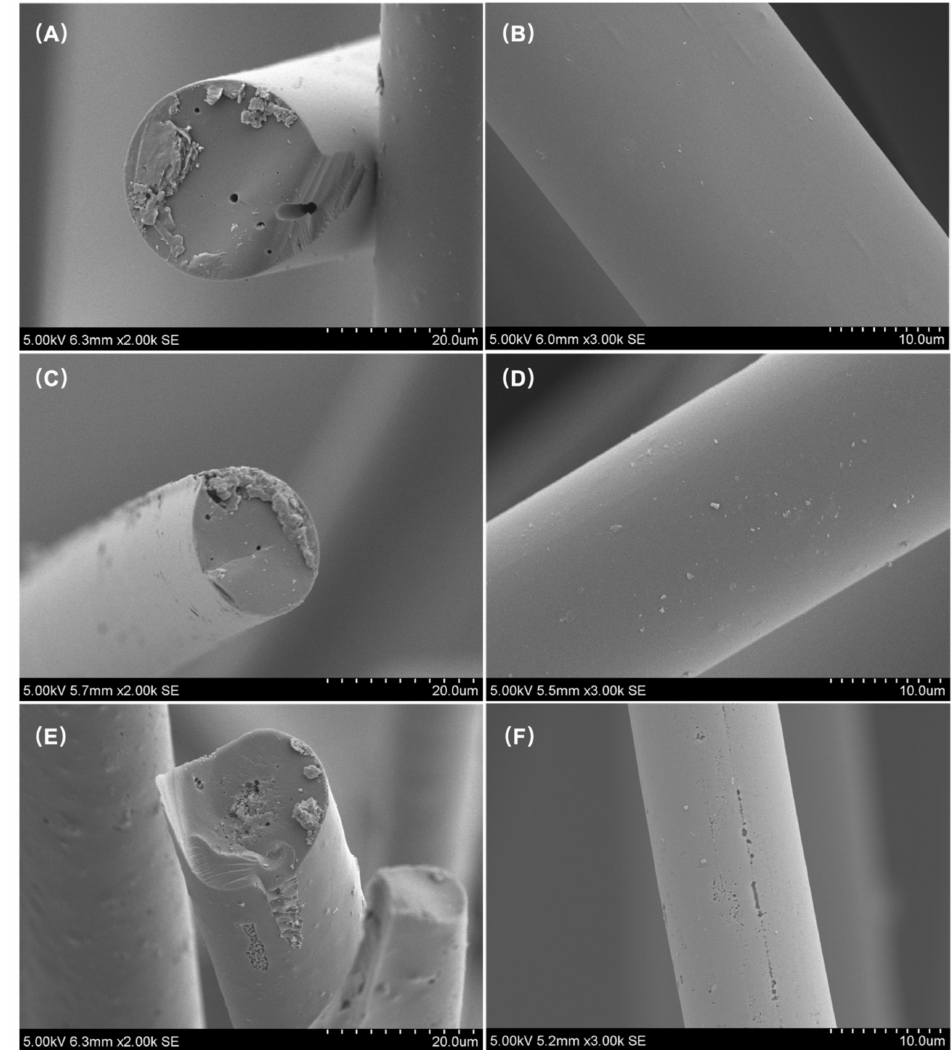
Figure 2. SEM images of LWACFs activated for 60 min ( A , B ), 140 min ( C , D ), and 220 min ( E , F ) at 800 ◦